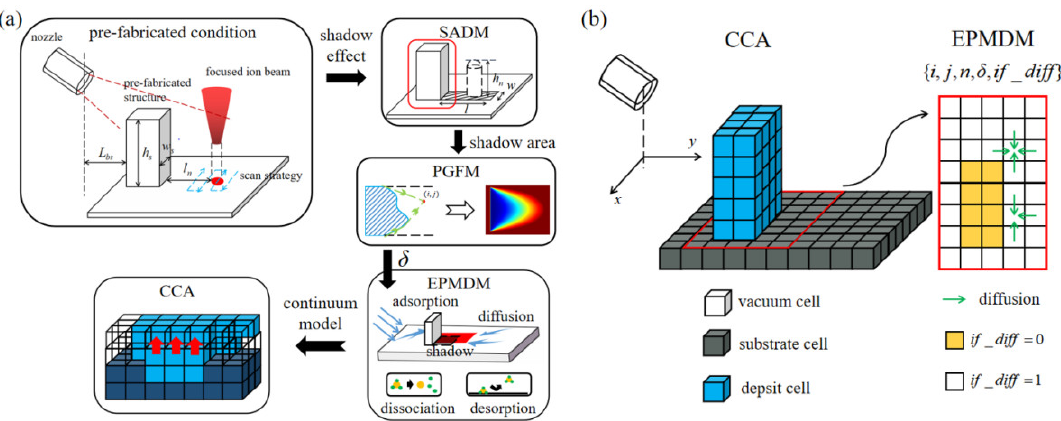
Figure 1. ( a ) The workflow of SADM, PGFM, EPMDM, and CCA; ( b ) schematic diagram of the CCA and EPMDM.